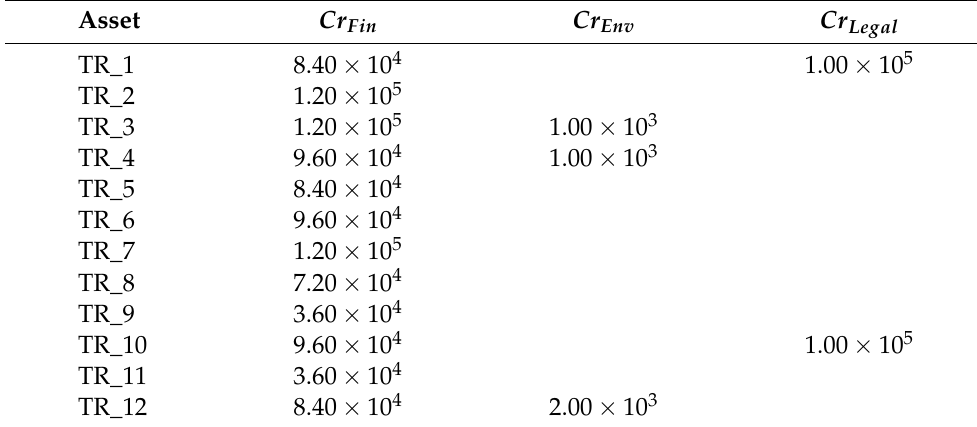
Table 1. Assumed criticality for the asset fleet.